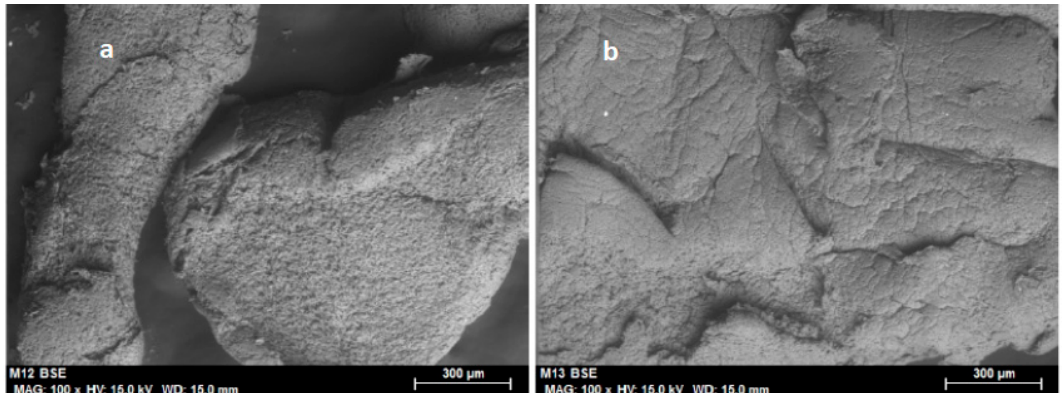
glutaraldehyde (red line) and ( b ) 20 μ L glutaraldehyde (blue line).